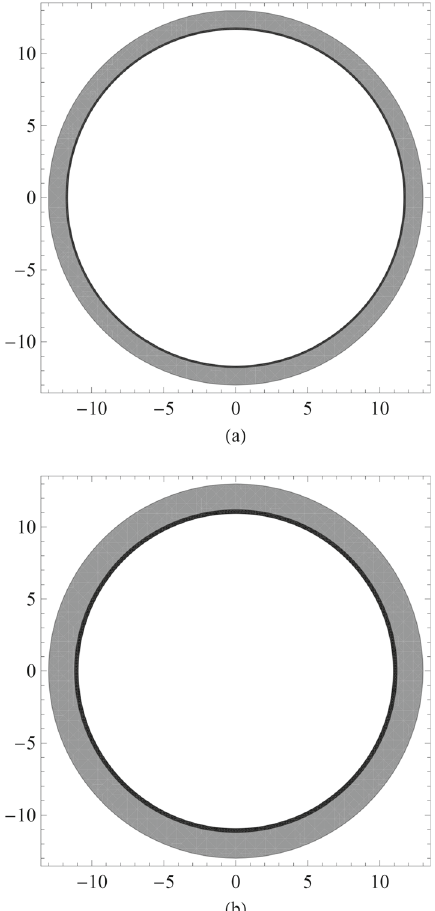
Fig. 22 Cross sectional view of the star EXO1745-248 for different stability region of quarks. Here inner region marked with white colour represents stable quark relative to 56 Fe above which a thin layer of metastable quark exists which is shown in black colour and the outer layer in gray colour consists of unstable quarks. Figure in the top panel ( a ) is plotted without charge ( γ = 0) and in the bottom panel ( b ) we consider the effect of charge and take γ = 0 . 2. The pressure anisotropy ( α ) is set to